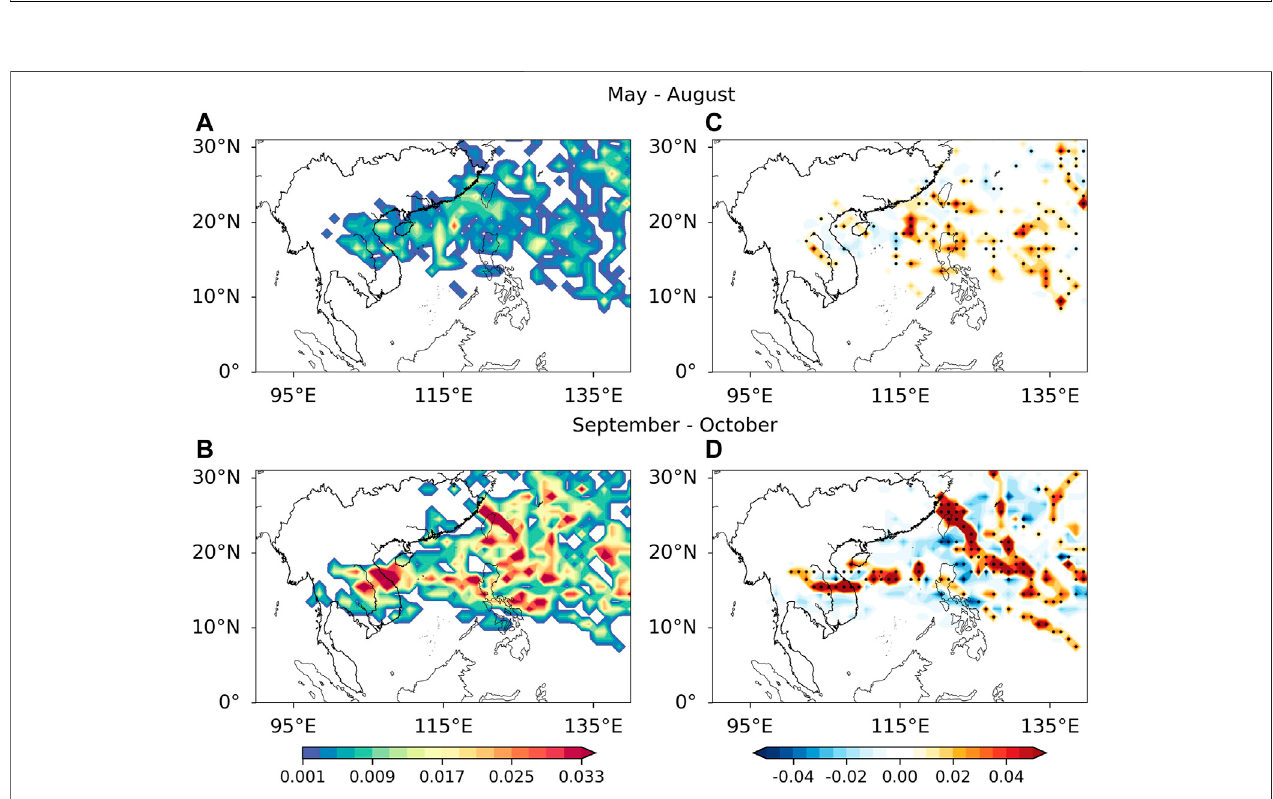
FIGURE 9 | The relative frequency of tropical cyclone center associated with extreme precipitation during (A) May – August and (B) September – October over 1951 – 2015. (C , D) asin (A , B) , but for thedifferences in frequency oftropical cyclonecenterassociatedwith extreme precipitation during the subperiods of 1951 – 2002 and 2003 – 2015. Only differences that are statistically signi fi cant at the 90% con fi dence are stippled in (C , D) .